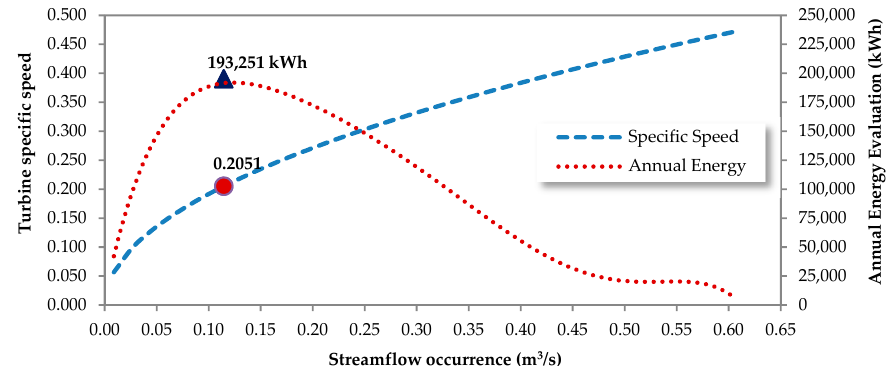
Figure 10. Results of annual energy evaluation and turbine type selection from the first phase of the algorithm (Figure 9) in 200 classes.